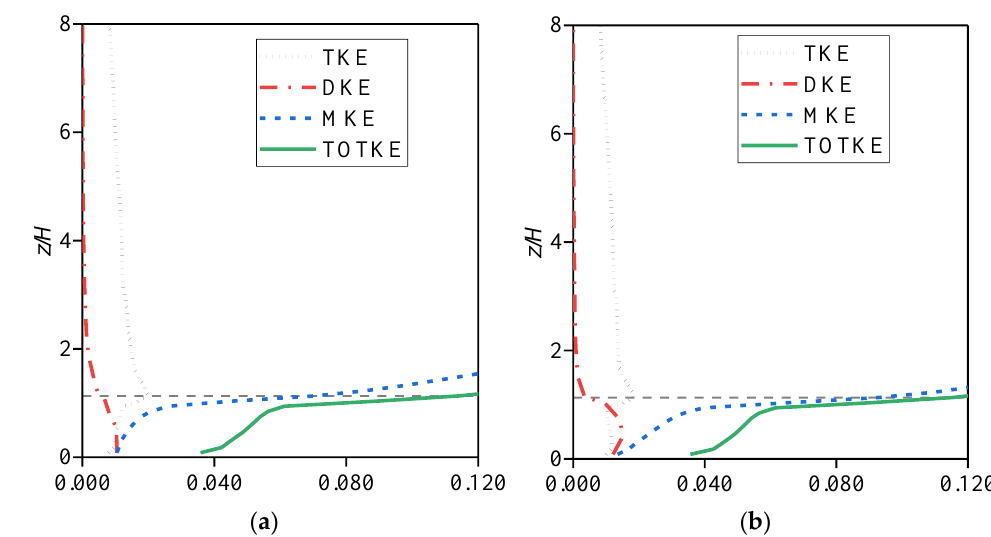
Figure 18. Profiles of TKE, DKE, MKE, and TOTKE for cases of ( a ) distorted wind passages DWP and ( b ) streamlined wind passages SWP.